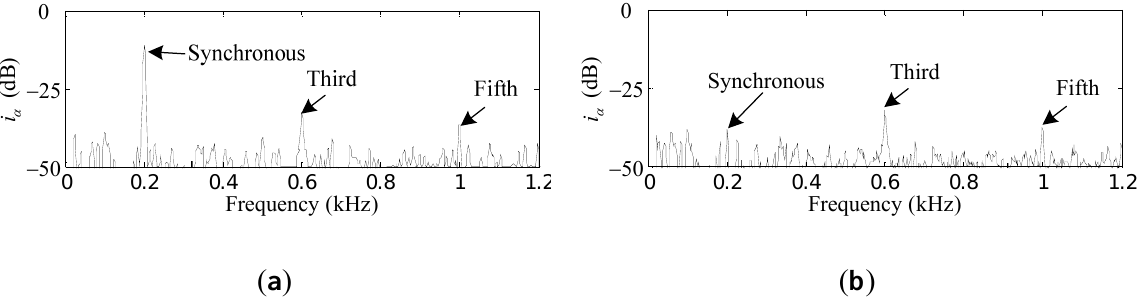
Figure 18. Experiment results of i α : ( a ) before synchronous current reduction; ( b ) after synchronous current